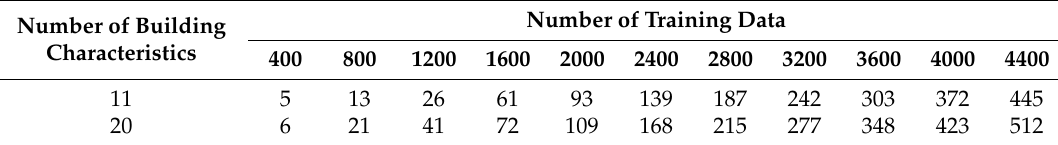
Table 3. The computational time for each experiment(s).